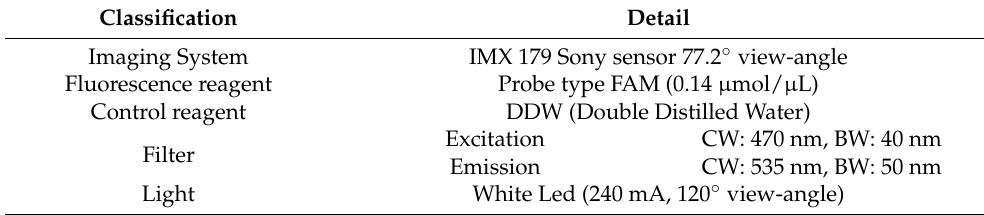
Table 1. System components.